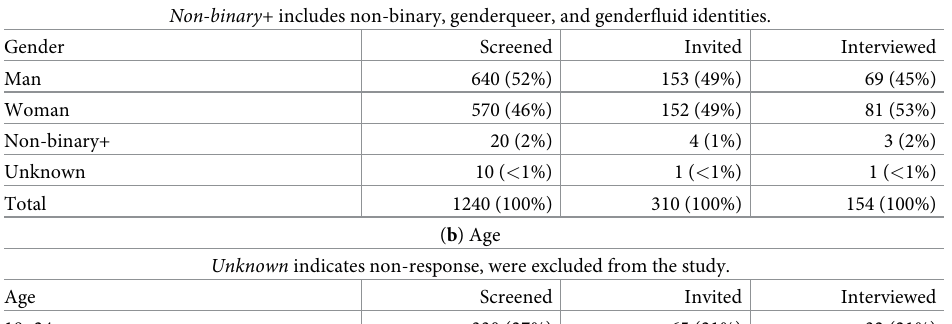
( a ) Gender Non-binary+ includes non-binary, genderqueer, and genderfluid identities. Gender Screened Invited Interviewed